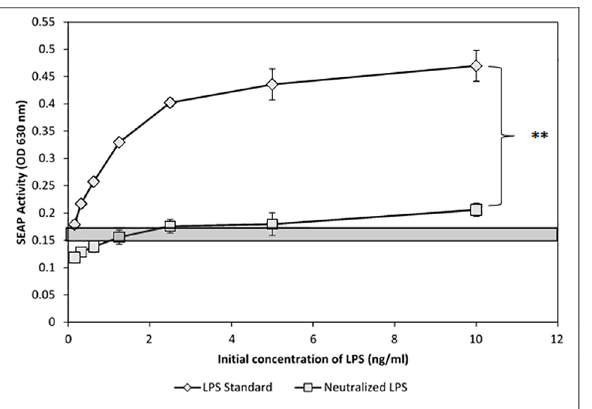
Fig 3. Polymyxin B depletion of LPS from spiked-positive control samples abolishes SEAP responses. To demonstrate the effectiveness of LPS depletion, samples of LPS-spiked media (0.16–10ng/ ml) were incubatedtwice on polymyxincolumns with gentle rockingat room temperature. After elution from the columns, the effluents were appliedto TLR4-reportercells (as performed in Fig 2) and the stimulationwas assessedwith QuantiBlue. The gray bar representsthe mean background of SEAP activity +/- SEM). The % net changein O.D. (HEK treatment O.D. minus background O.D.) produced by polymyxin depyrogenation of 10 ng/ml LPS was determinedto be 89%. Significance is representedby the asterisks, p (cid:20)